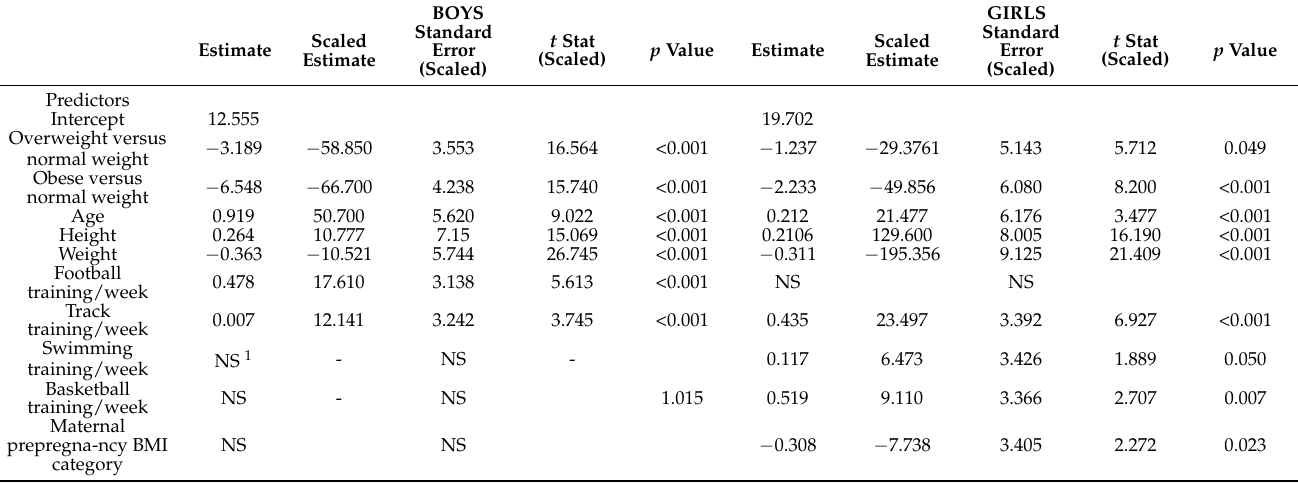
Figure 7. Scatterplots for actual and predicted values using SVR-RBF and MLR for girls (tuned model): ( a ) SVR-RBF; ( b ) MLR. Table 6. Ridge Regression